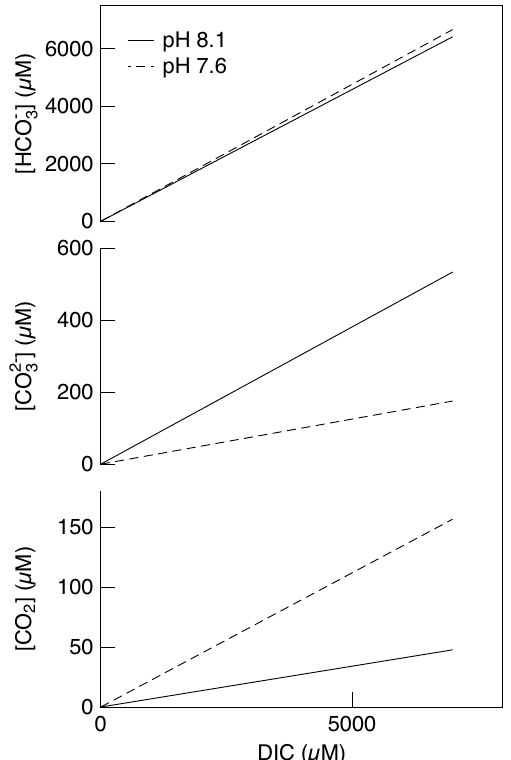
Figure 4. The concentrations of CO 2 , CO 3 2− and HCO 3 − in the ambient pH 8.1 and the low pH 7.6 treatment from the DIC uptake laboratory experiments. The low pH conditions cause a shift in the speciation to a higher concentration of CO 2 and a lower concentration CO 3 2− within the seawater. Values were calculated using the ‘seacarb’ package 42 in R, using a temperature of 12 °C and a salinity of 35 psu, with the assumption that the photosynthesis of the ~ 1 g individuals during the incubations did not have a significant impact on the carbonate chemistry within the